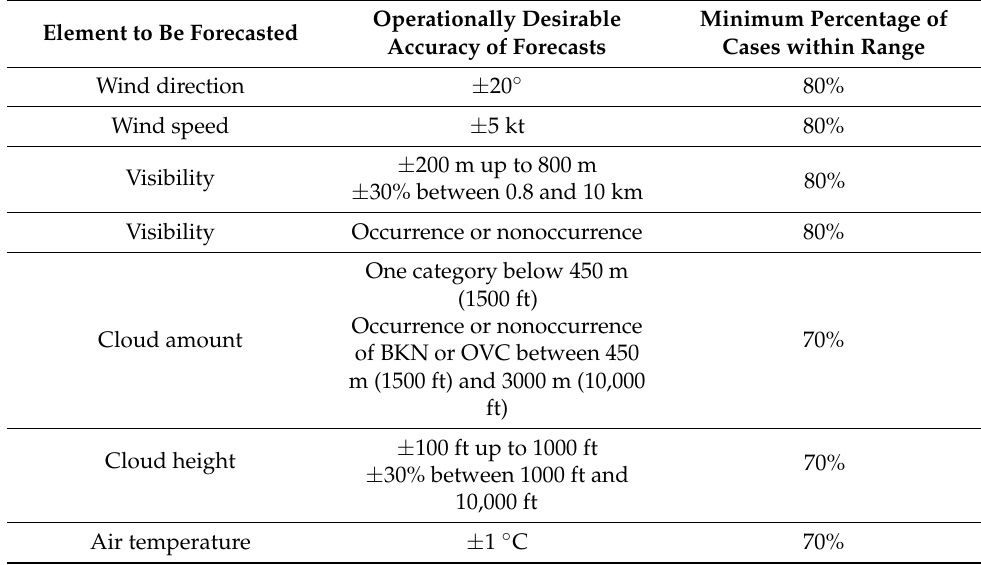
Table 4. Operationally desirable accuracy of